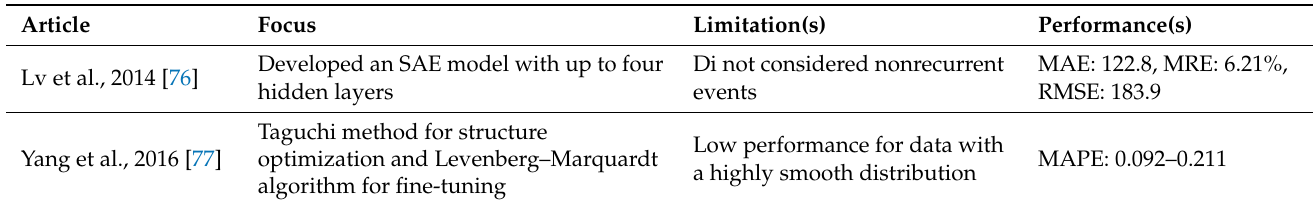
Table 11. Summary of the works found using